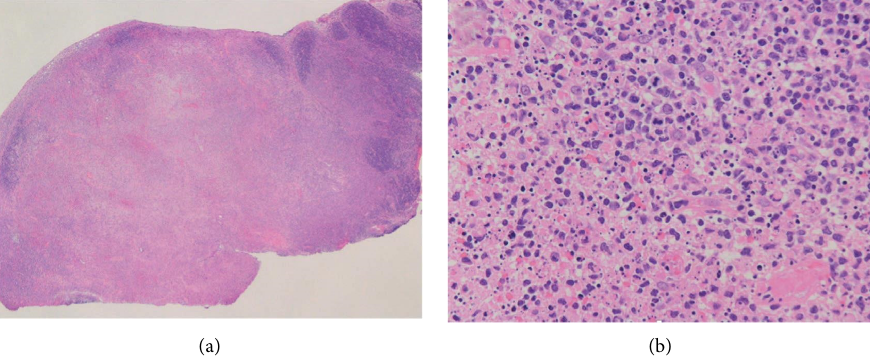
Figure 1: A histopathological image of axillary lymph node biopsy performed on the fourth day of admission. (a) Low power feld, the central part of the lymph node was necrotic. (b) Hyper power feld, macrophages with numerous nuclear karyorrhectic debris were observed in the necrotic tissue. Te biopsied lymph node showed no neutrophilic